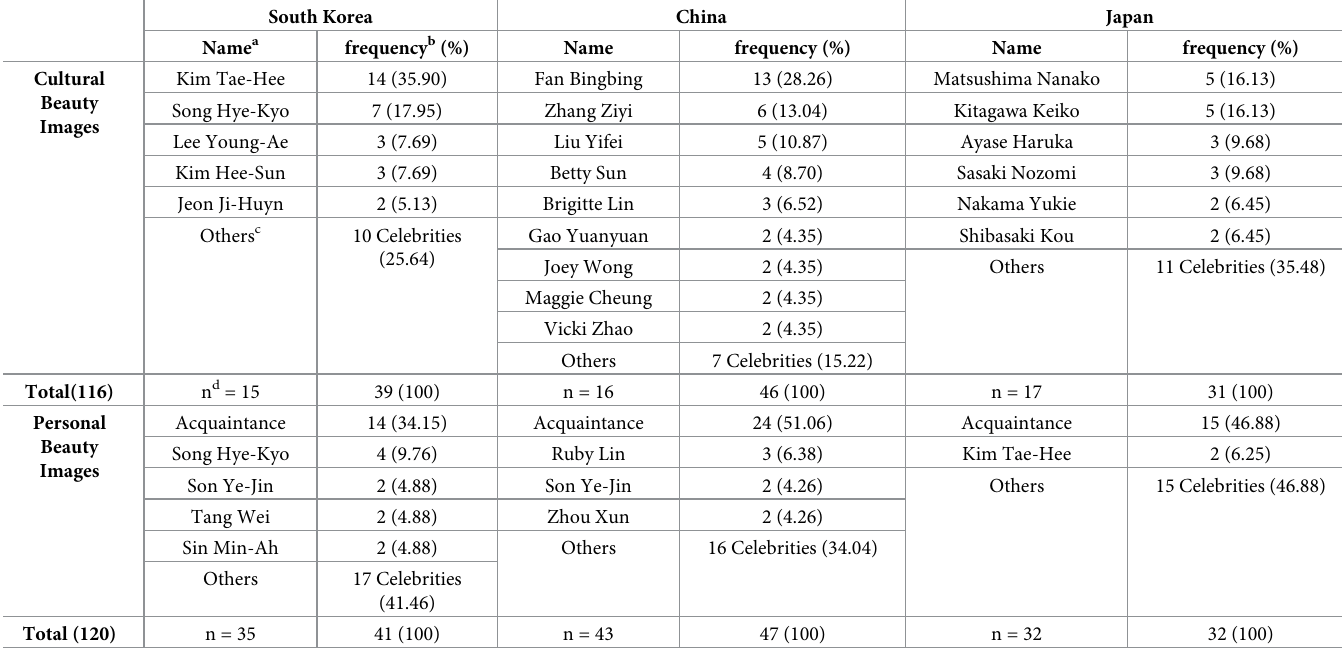
Table 3. Information on the stimuli of cultural beauty and personal